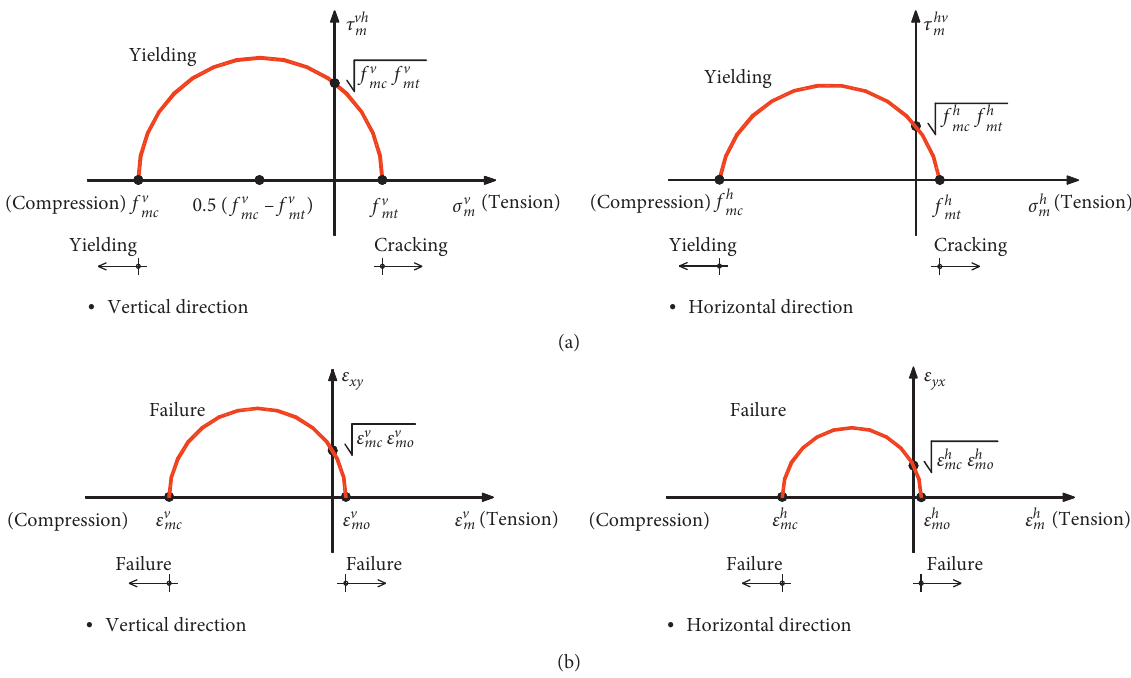
Figure 2: Adopted orthotropic masonry model under normal and shear stresses: (a) the yielding of the masonry; (b) the failure of the